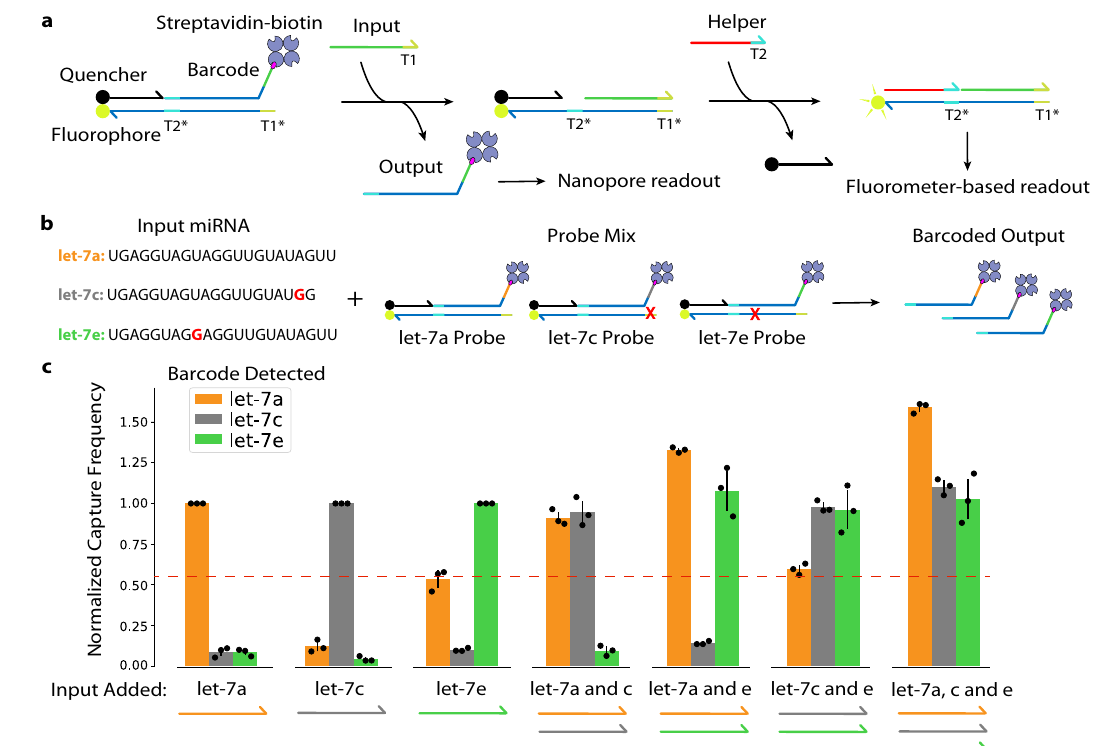
Fig. 5 | Multiplex detection of let-7 microRNA SNV variants. a Two-step probe mechanism. miRNA input hybridizes to the fi rst toehold region (T1) on the bottom strand, displacing the barcoded output strand for nanopore readout. Next, a helper strandhybridizestothesecondtoeholdregion(T2)onthebottomstrand,displacing the quencher strand and enabling spectro fl uorometer-based readout. b Multiplex experiment setup. Input strands are synthetic let-7 miRNA SNV variants (sequences shownwithSNVsboldedinred)whichareaddedtoamixofprobes.AredXdenotes